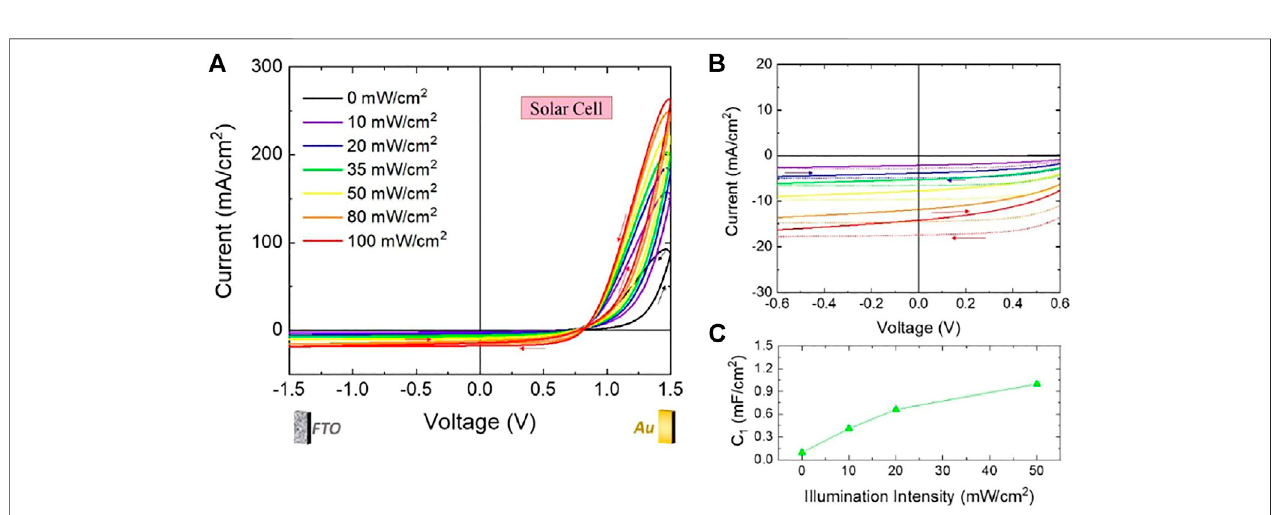
FIGURE7|(A) Currentdensity – voltage characteristicofanFTO/c-TiO 2 usingablue 2 /m-TiO 2 /MAPI/spiro-OMeTAD/Au solarcellmeasured from 0to100 mW/cm light source (470 nm) and 0.1 cm 2 active area. A positive current fl ow from FTO to the Au electrode. (B) A magni fi ed view of the scale. Lines represent the forward scan, while dots represent the reverse scan. (C) Low-frequency capacitance enhancement with illumination intensity for an FTO/c-TiO 2 /m-TiO 2 /MAPI/spiro-OMeTAD/Au solar cell.